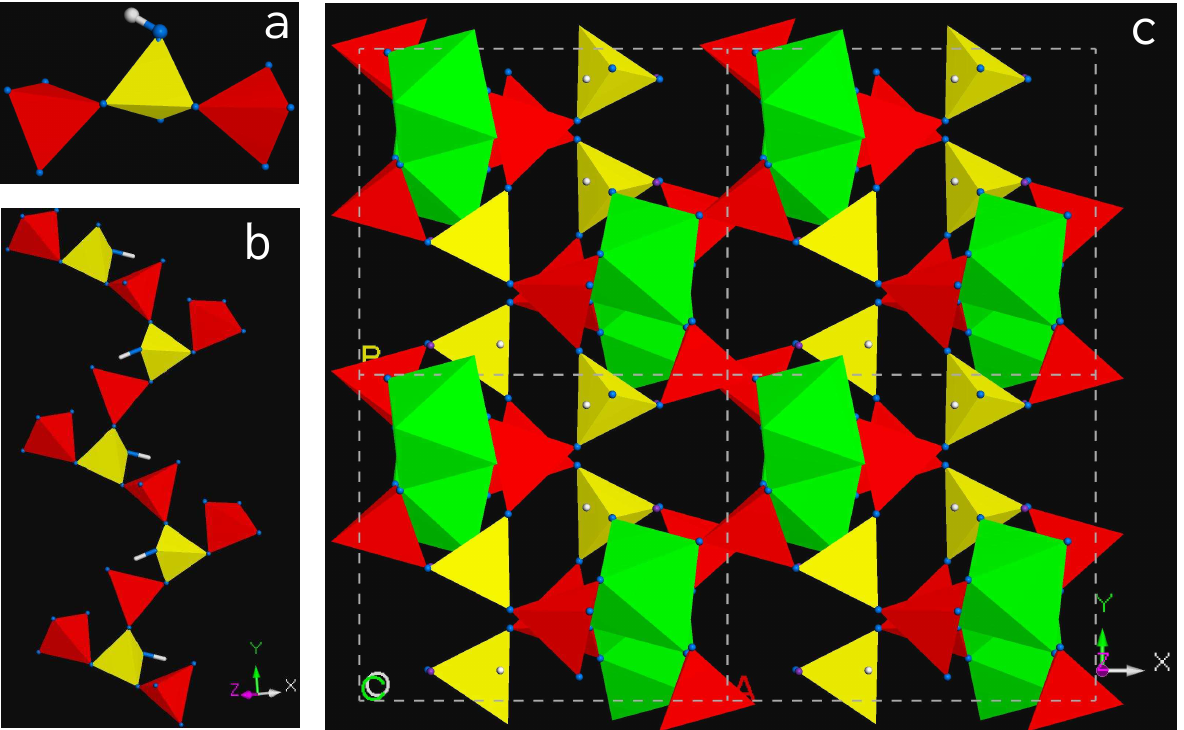
Figure 2. a : Trimeric borophosphate basic building unit; b : open-branched vierer chain 1 4- } FBU; c : view of the open-framework structure of KFe[BP ∞ {[BP 2 O 8 (OH)] along the [001] direction showing irregular 8-ring channels (color code: Fe, green; B, yellow; P, red; O, blue; K, purple; H,